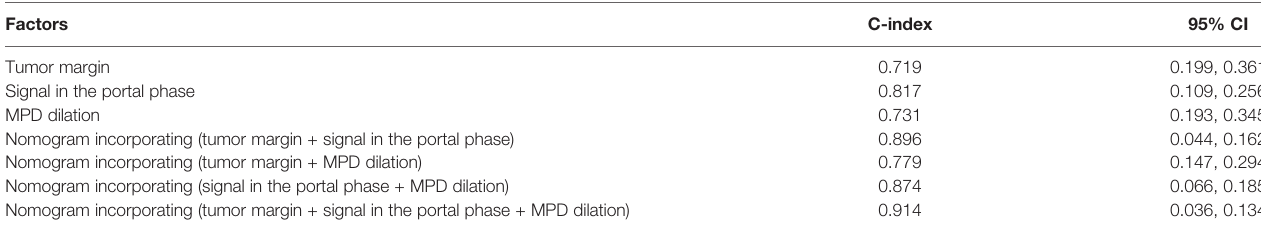
TABLE 4 | Discriminatory capabilities of the nomogram and independent MRI features.